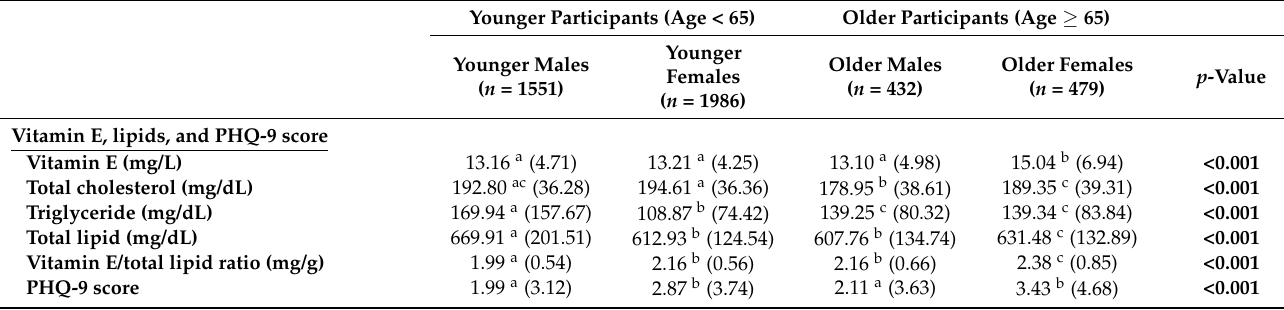
Table 1. Baseline characteristics of the study